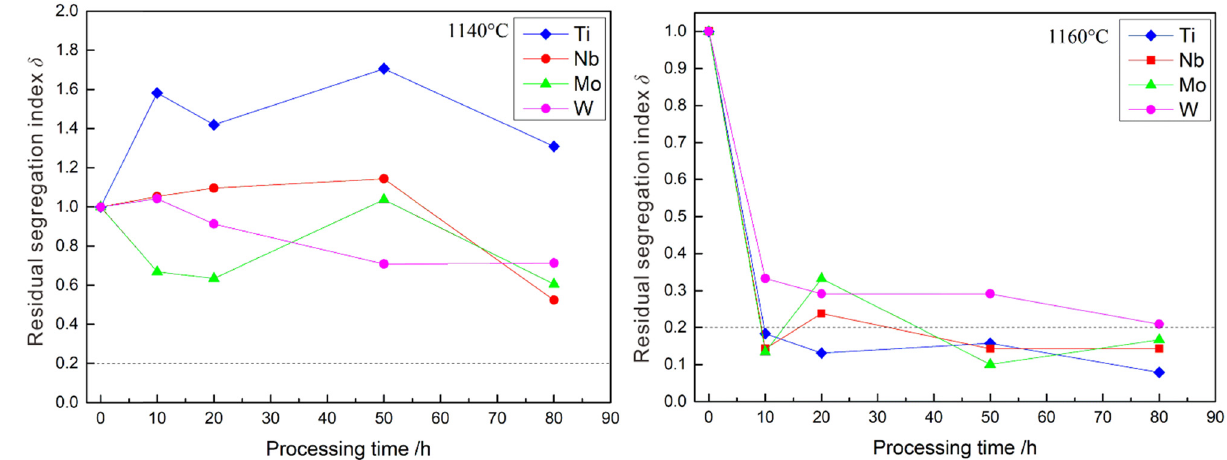
Figure 10: Residual segregation index evolution of samples from Disk II at a variety of